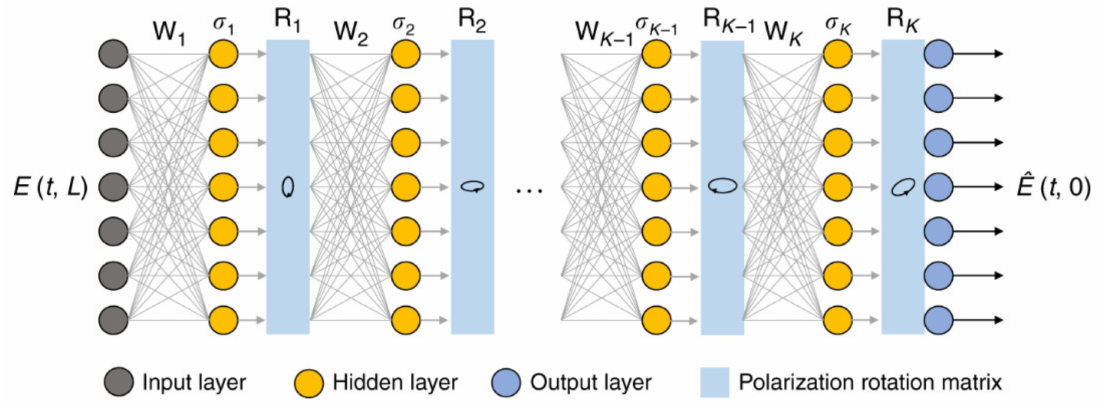
Figure 17. The architecture of DNN to implement DBP and PSP derotation.